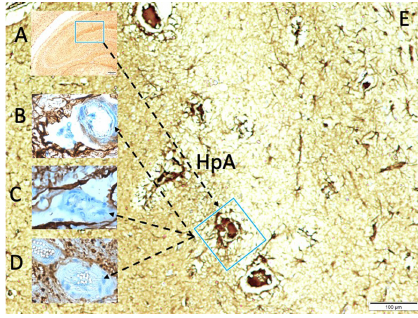
Figure 4. The appearance of the hippocampus and arteries is normal in the control group. A normal hippocampal artery in perivascular space filled with transparent CSF is seen in the control group. A slightly narrowed artery surrounded by few defense cells is seen in the sham group, and a significantly narrowed artery surrounded by a large number of defense cells is observed in a significantly narrowed perivascular space in the study group.